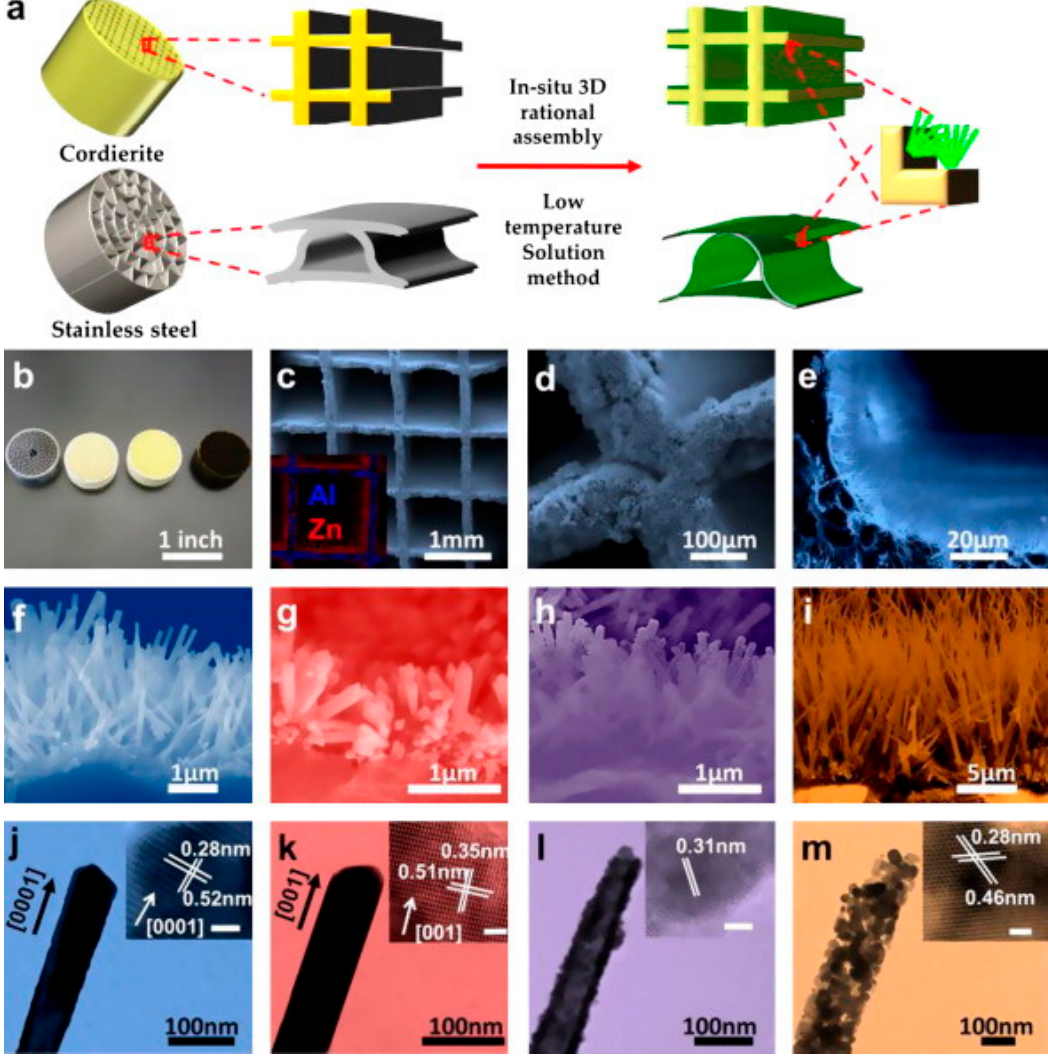
Figure 1. ( a ) Schematic illustration for the nano-array growth onto the three-dimensional (3D) monolithic cordierite and stainless steel substrate by hydrothermal synthesis; ( b ) Photographs of monolithic nano-array catalysts with various nano-arrays deposited; ( c ) low-magnification SEM image of a ZnO nano-array catalyst with inset showing the element distribution; ( d , e ) low magnification top and cross-sectional SEM images of nano-arrays; ( f – i ) cross-sectional SEM images of ( f ) ZnO nanowire arrays; ( g ) TiO 2 nanorod arrays; ( h ) CeO 2 nanotube arrays; ( i ) Co 3 O 4 nanowire arrays; ( j – m ) corresponding TEM characterization of nano-arrays shown in ( f – i ). Reprinted with permission from [36], Copyright Elsevier,